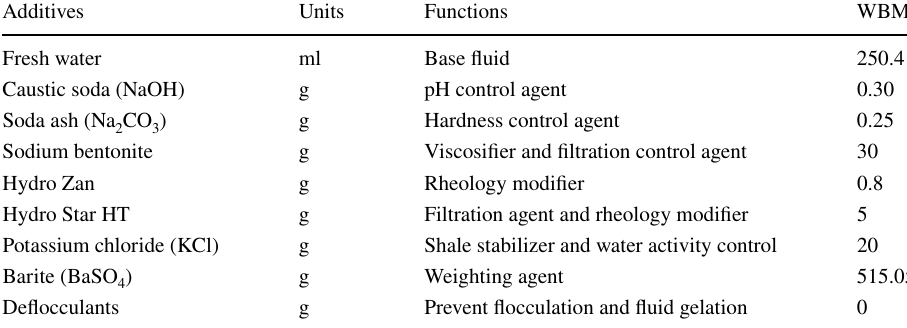
Table 1 Water-based mud formulation for laboratory scale, equivalent to 1 lab.